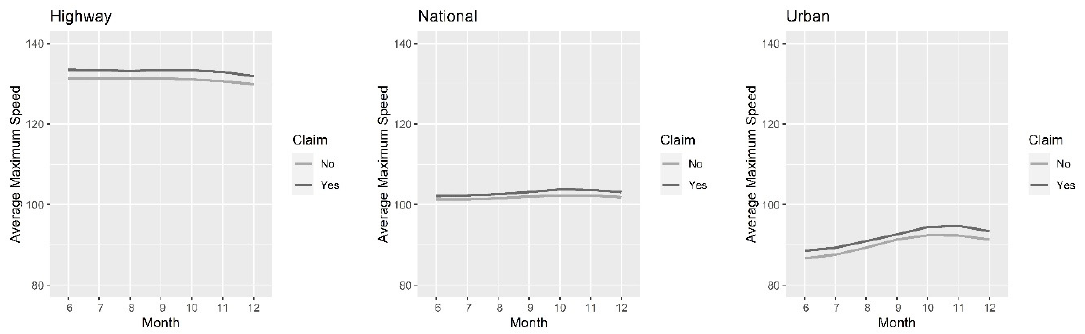
Figure 1. Plots of the average maximum speed per individual from month 6 to month 12 in terms of whether or not individuals reported claims at some point over the entire period. From left to right there is a graph for the maximum speed on highways, national roads, and urban roads, respectively.